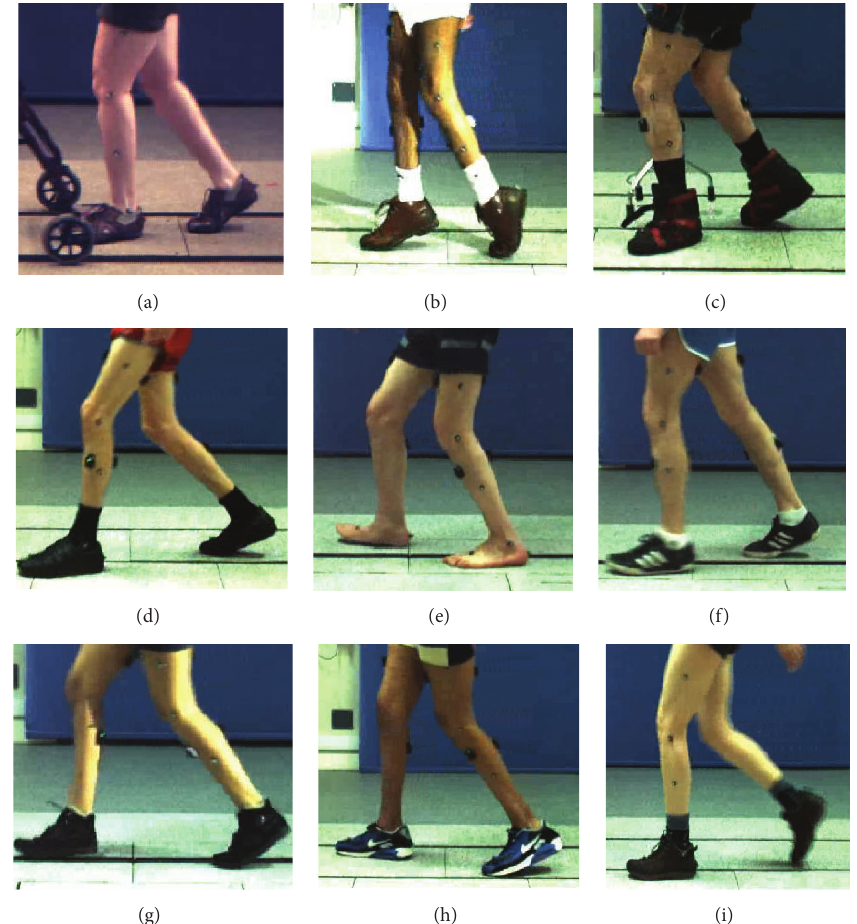
Figure 1: (a–i) Gait analysis of nine poststroke patients with a paretic leg in the gait